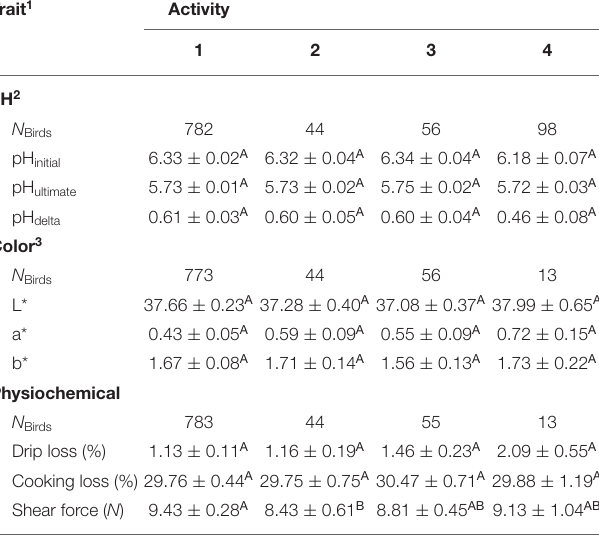
TABLE 3 | Linear models for the effect of post mortem activity (score 1–4), genetic line (A–F), and season (summer vs. autumn) on turkey meat quality traits ( N Birds = 817–895 depending on trait).